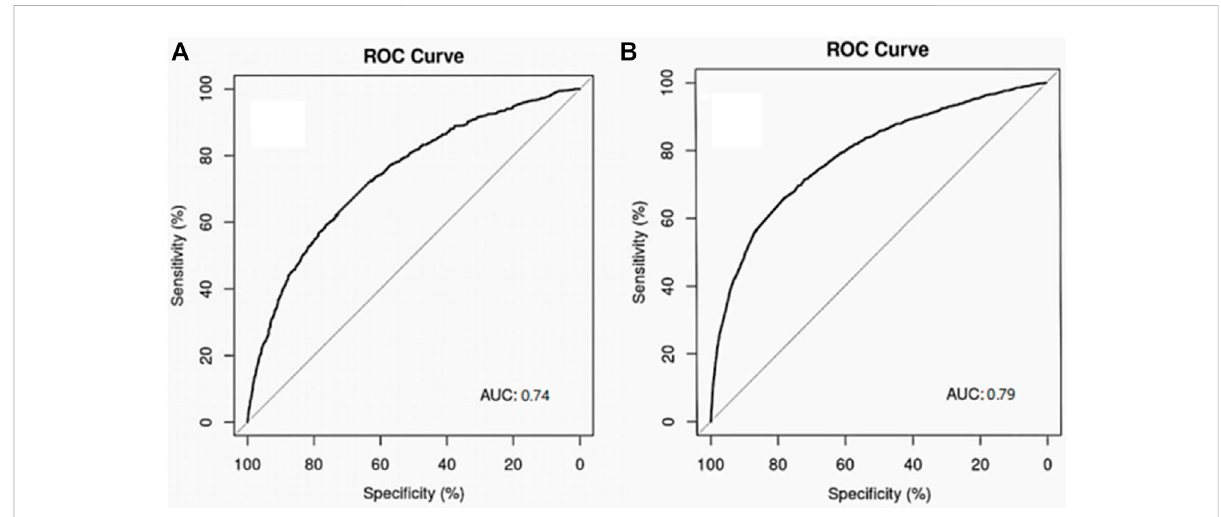
FIGURE 2 Performance of logic regression models for AKI related to torasemide and furosemide. (A) Torasemide; (B)